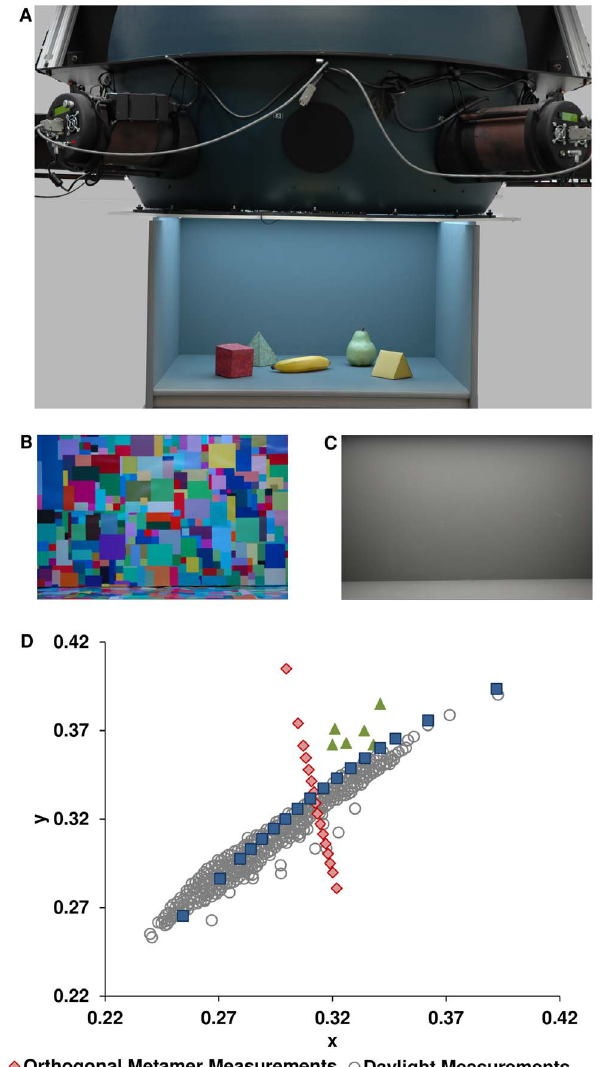
Figure 1. Photographs of the illuminator equipment and the scene backgrounds, with a plot of the chromaticity coordinates of illuminations used in the experiment. A. Photograph of illuminator and the viewing box (with front wall removed) under extreme blue illumination, with fake pear, banana and chromatically matched novel objects. B. The Mondrian background used for the variegated scene condition, under D67 illumination. C. The grey background used for the grey scene condition. D. Chromaticities of generated metamers atop daylight measurements taken and digitised from Hernandez-Andres et al. [36], in CIE 1931 colour space; green markers show chromaticities of Ugandan forest canopy illuminations measured by Sumner and Mollon